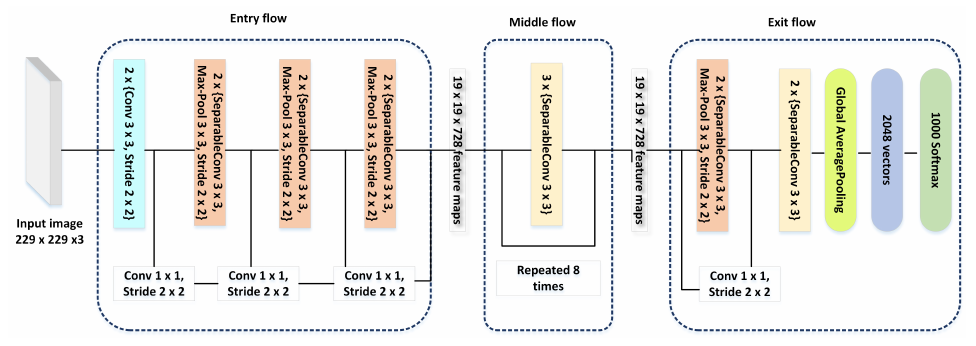
Figure 5. InceptionV3 model architecture.